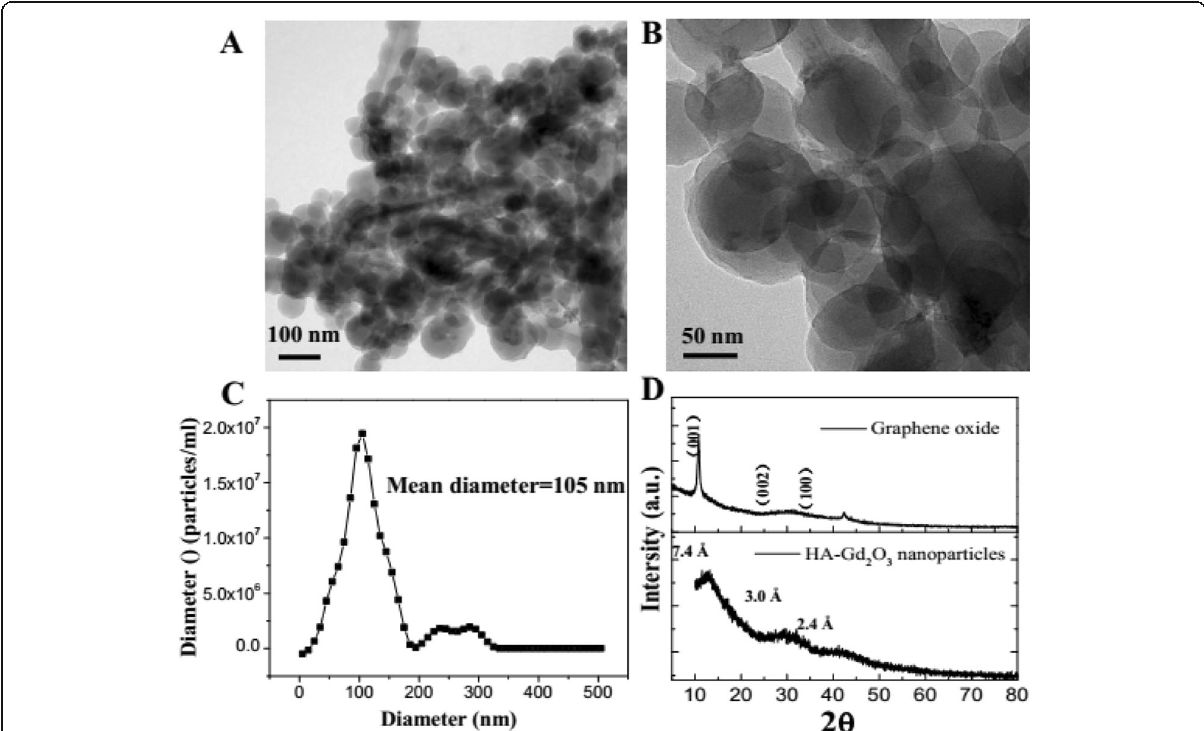
Fig. 1 Characterization of HA-Gd 2 O 3 NPs. Low ( a ) and high ( b ) magnification TEM images. The diameter distribution ( c ) and XRD patterns ( d ) of HA-Gd 2 O 3